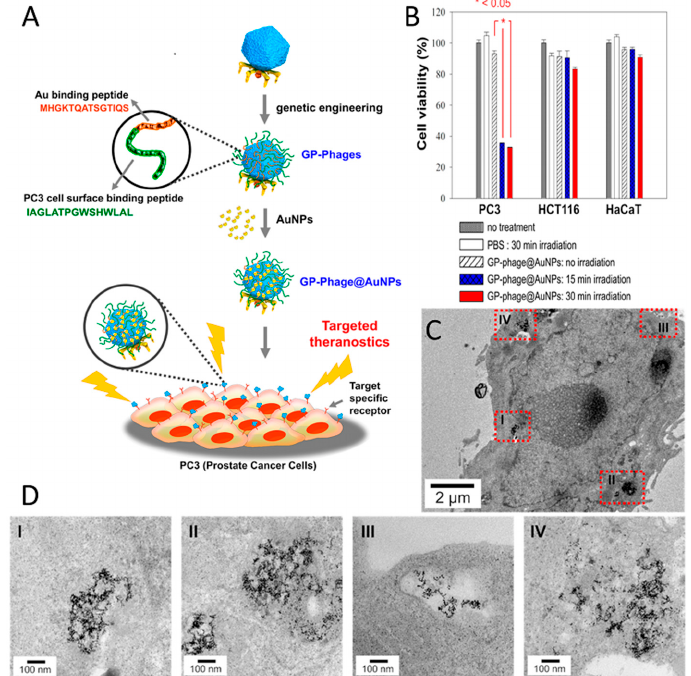
Figure 5 . ( A ) Schematic illustration of cancer-selective photothermal therapy via prostate intracellular delivery of T7-templated AuNP nanoclusters, where T7 phages are genetically modified to display gold-binding and prostate cancer cell-targeting peptides on the viral surface. ( B ) The viability of each cell line (prostate cancer cell (PC3), human colorectal carcinoma cells (HCT116), and normal cells (HaCat)) by photothermal effects of T7-templated AuNP nanoclusters. ( C , D ) TEM images of T7-templated AuNP nanoclusters internalized within PC3 cells in ultrathin section specimens. The cells were treated with T7-templated AuNP nanoclusters for 5 h, followed by medium replacement and additional incubation for 20 h (Adapted with permission from [206], Copyright American Chemical Society,